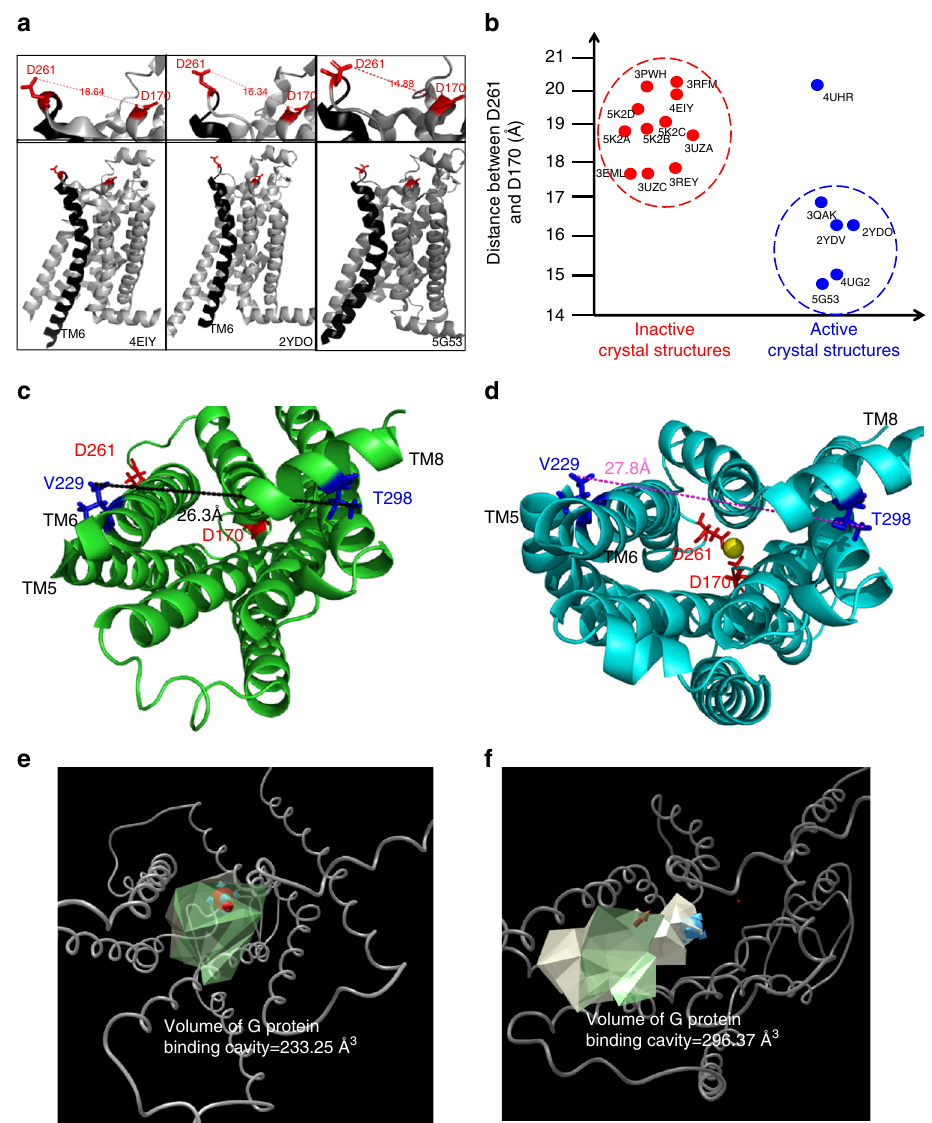
Fig. 8 Topology of D261-D170 and effects of its bridge on the G-protein-binding cavity. a Distances between residues D261 and D170 in crystal structures of inverse agonist (PDB:4EIY) bound-, agonist(PDB:2YDO) bound- and engineered G protein (PDB:5G53) bound-A 2A R receptors. b Distribution of inter- residue distances, D261-D170, from all available A 2A R crystal structures in the PDB database. Note the above distances refer to those between the most proximal atoms from each residue. c , e Bottom view of the intracellular G-protein-binding domain of the apo sample revealing the extent of opening of the G-protein-binding cavity through the distance between V229 (TM6) and T298 (TM8) ( c ), and the volume of the cavity ( e ). d , f Bottom view of the intracellular G-protein-binding domain at the conclusion of the MD trajectory, showing the resultant distance between V229 (TM6) and T298 (TM8) ( d ), and the volume of the G-protein-binding cavity after engagement of the divalent cation ( f